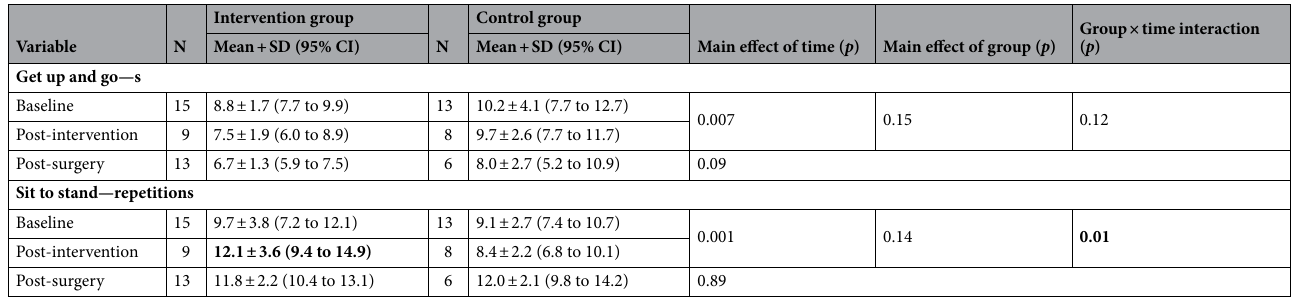
Table 3. Results for physical outcome measures. SD standard deviation, CI confidence interval, ROM ranges of motion. Bold indicate a significant intra-group change from baseline. *Denotes a significant between group difference.